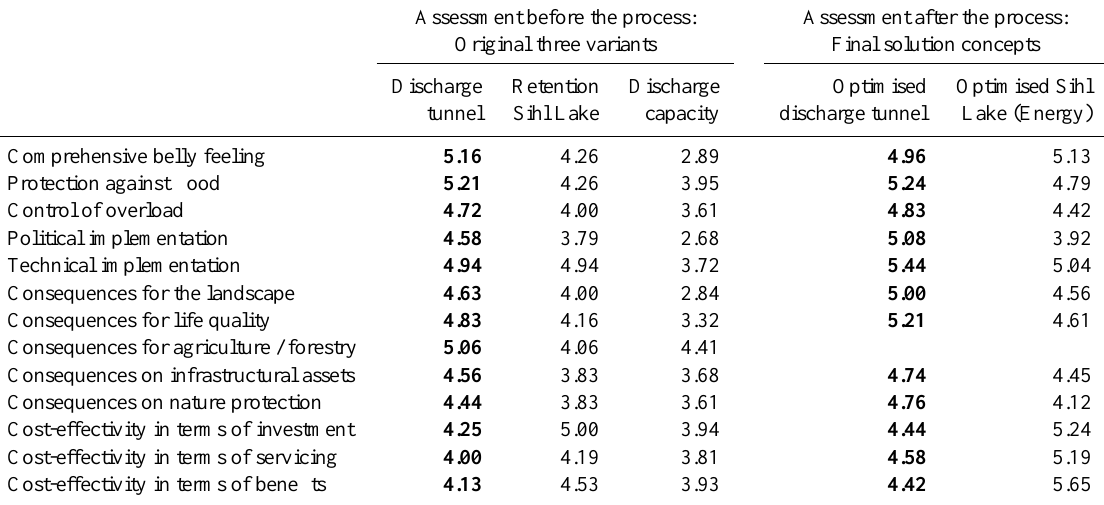
Table 4. Mean values of participants’ assessments of the flood prevention variants of the Sihl according to 13 criteria before ( N = 20) and after the assessment process ( N = 25). Participants assessed the criteria on a 6-point scale (1 = “fully insufficient” to 6 = “very good”). Assessment before the process: